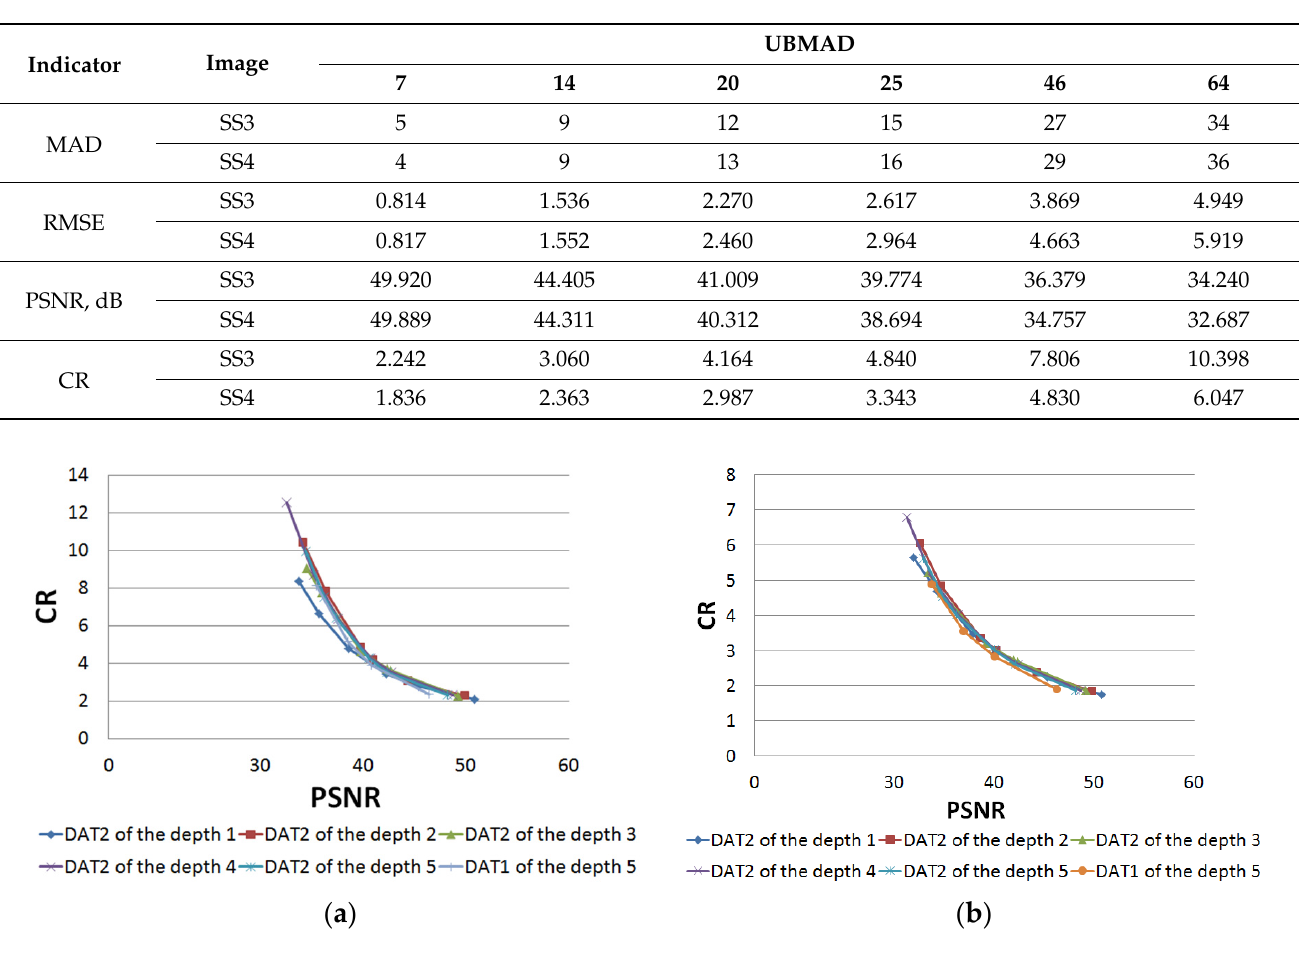
Table 5. Results of compressing SS3 and SS4 using DAC with DAT2 of the depth 2.